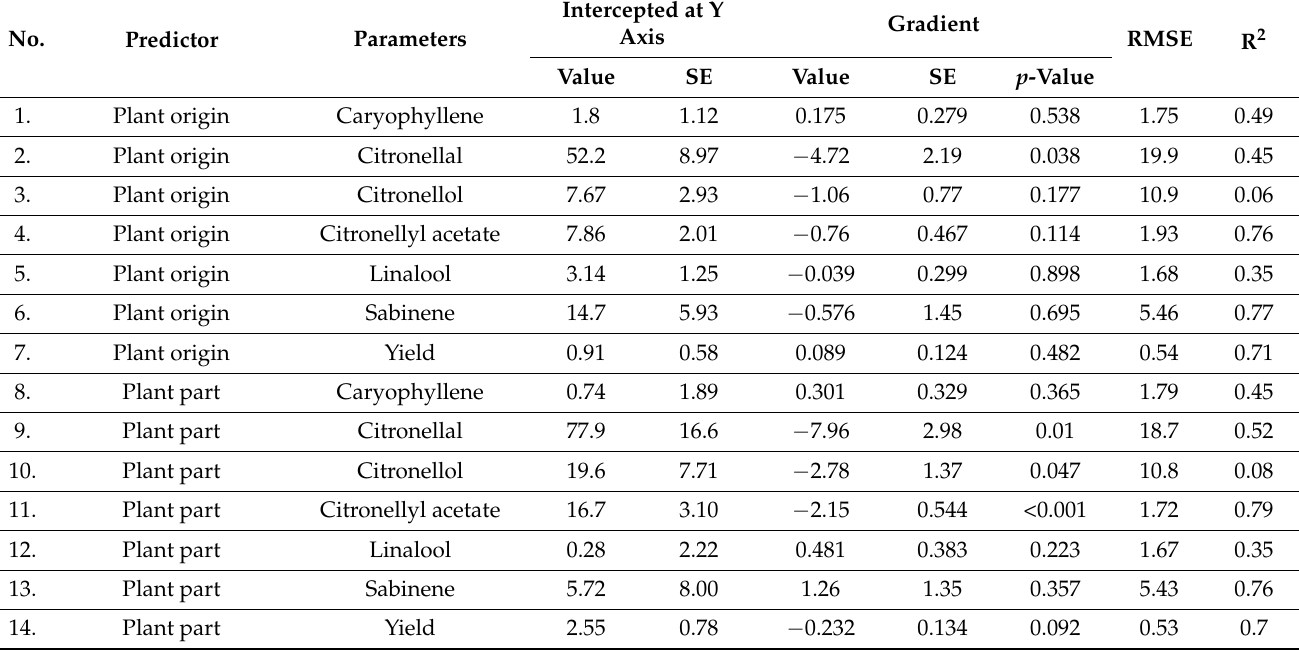
Table 4. Meta-regression of yield and main components of kaffir lime essential oil in response to plant origin, plant part of sample, and extraction